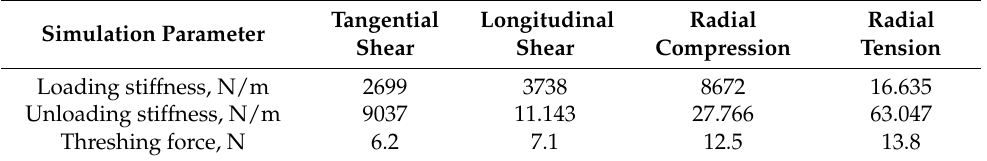
Table 3. Simulation parameters of contact bonding model between the kernel and the